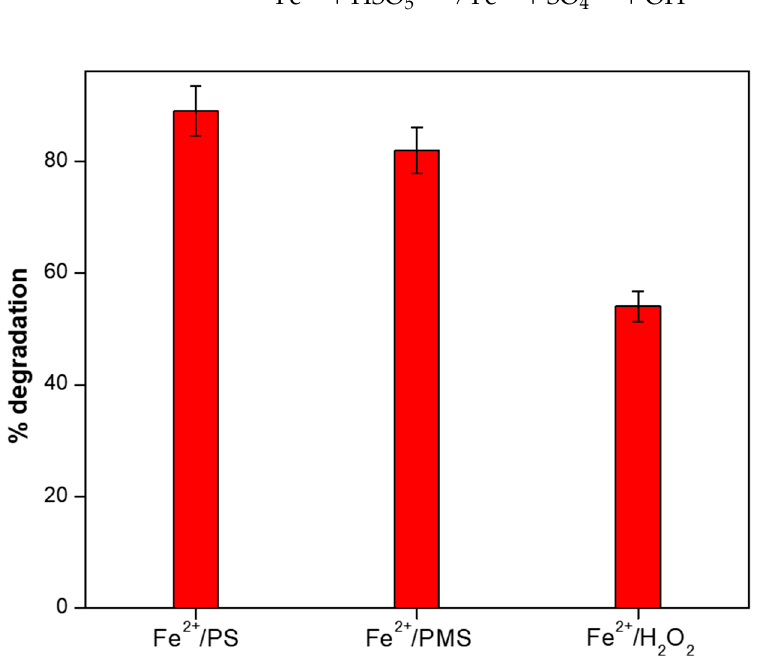
Figure 2. Degradation efficiency of DCF sodium by Fe 2+ /H 2 O 2 , Fe 2+ /PS and Fe 2+ /PMS systems in 60 min. Reaction conditions: [DCF sodium] 0 = 0.3 mM, [Fe 2+ ] 0 = 0.5 mM, [H 2 O 2 ] 0 = [PS] 0 = [PMS] 0 = 10 mM, pH = 4.